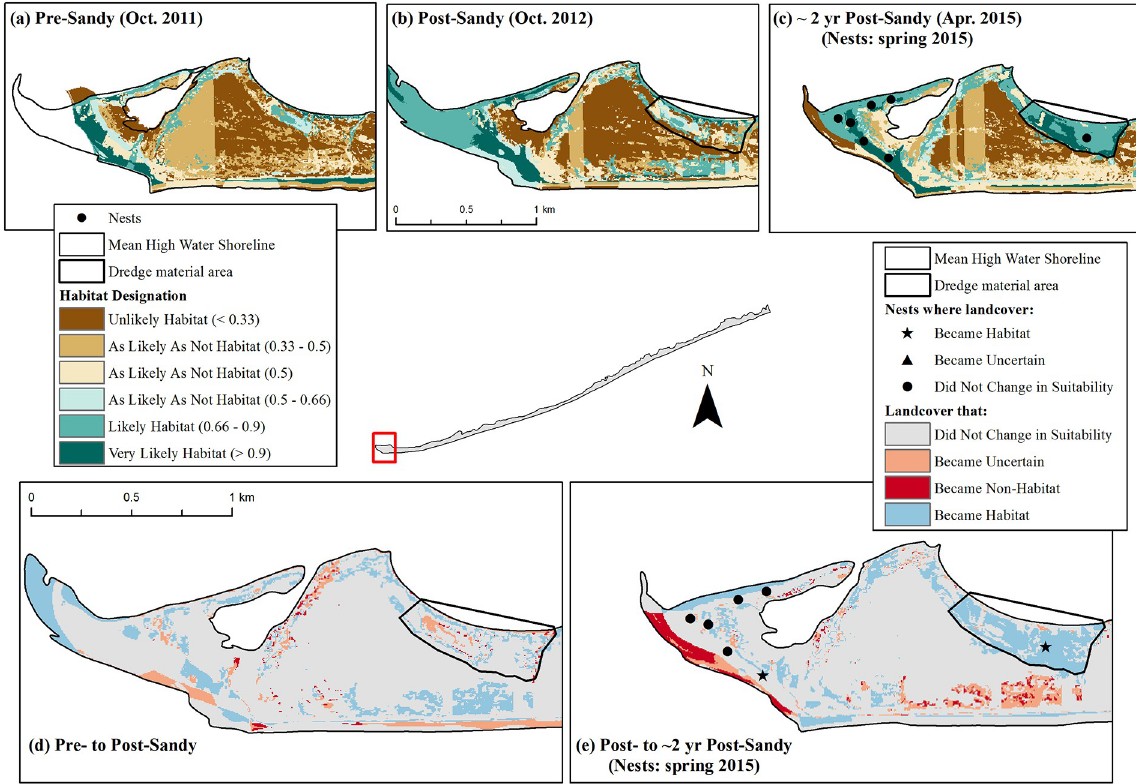
Fig 4. Examples of habitat change before Hurricane Sandy, immediately following Sandy, and ca. 2 years post-Sandy on the Fire Island, New York, study area 1 . Maps (a)-(c) show habitat in the year corresponding with the aerial imagery used for analysis, with piping plover nest points corresponding to the breeding season for which habitat was available 2 . Map (d) shows changes in habitat that ostensibly resulted from Hurricane Sandy, while map (e) shows changes in habitat since the hurricane occurred 3 . 1 In these maps, the habitat designation was predicted according to the Plover Habitat Bayesian network. Landcover that was very likely habitat had a � 0.90 probability of being habitat, landcover likely habitat had a probability of 0.66–0.90, landcover as likely as not habitat had a probability of 0.3–0.66, and landcover unlikely habitat had a probability � 0.33. We further differentiated the ‘as likely as not habitat’ category to show (1) areas of true model uncertainty ( p = 0.5), where the combination of habitat variables in a given landscape pixel was either not present in the supplemented iPlover dataset or where there was missing information in the ‘case’ presented to the BN for analysis in that pixel and (2) areas where landcover may be of marginal suitability (0.50 < p < 0.66; 0.33 < p < 0.50). 2 Nest locations contributed by [68]. 3 In these maps, habitat change was predicted by the Plover Habitat Bayesian network, where (d) considers change from the pre- to the post-Sandy study periods and (e) considers change from the post- to the 2 years post-Sandy study periods. Landcover that ‘became habitat’ transformed from as likely as not habitat or non-habitat to habitat; landcover that ‘became uncertain’ transformed from habitat to as likely as not habitat; and landcover that ‘became non-habitat’ transformed from habitat to non-habitat. Landcover that ‘did not change in suitability’ was either habitat, as likely as not habitat, or non-habitat in both study periods considered OR transformed from as likely as not habitat to non-habitat (or vice versa) between study